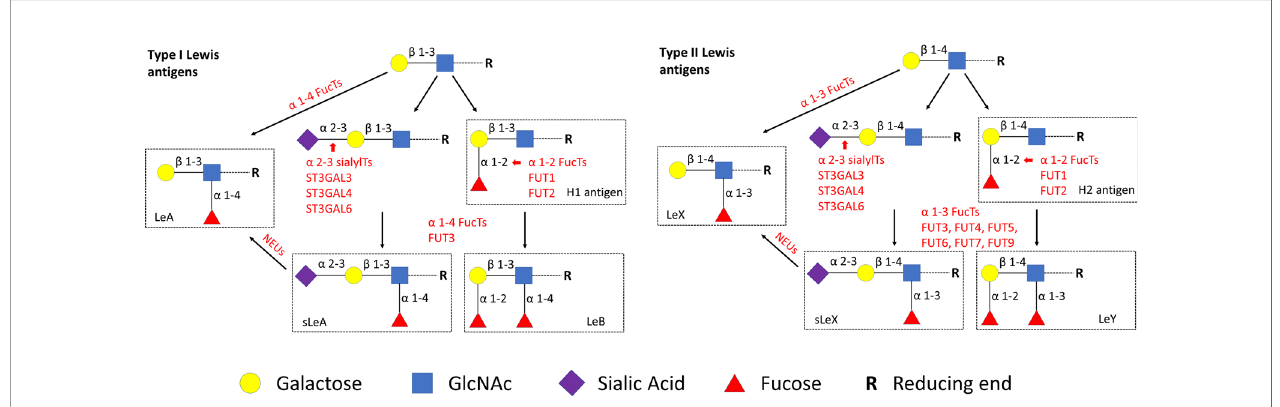
FIGURE 1 | Lewis antigens biosynthetic pathways. GlcNAc, N-acetylglucosamine. NEUs,